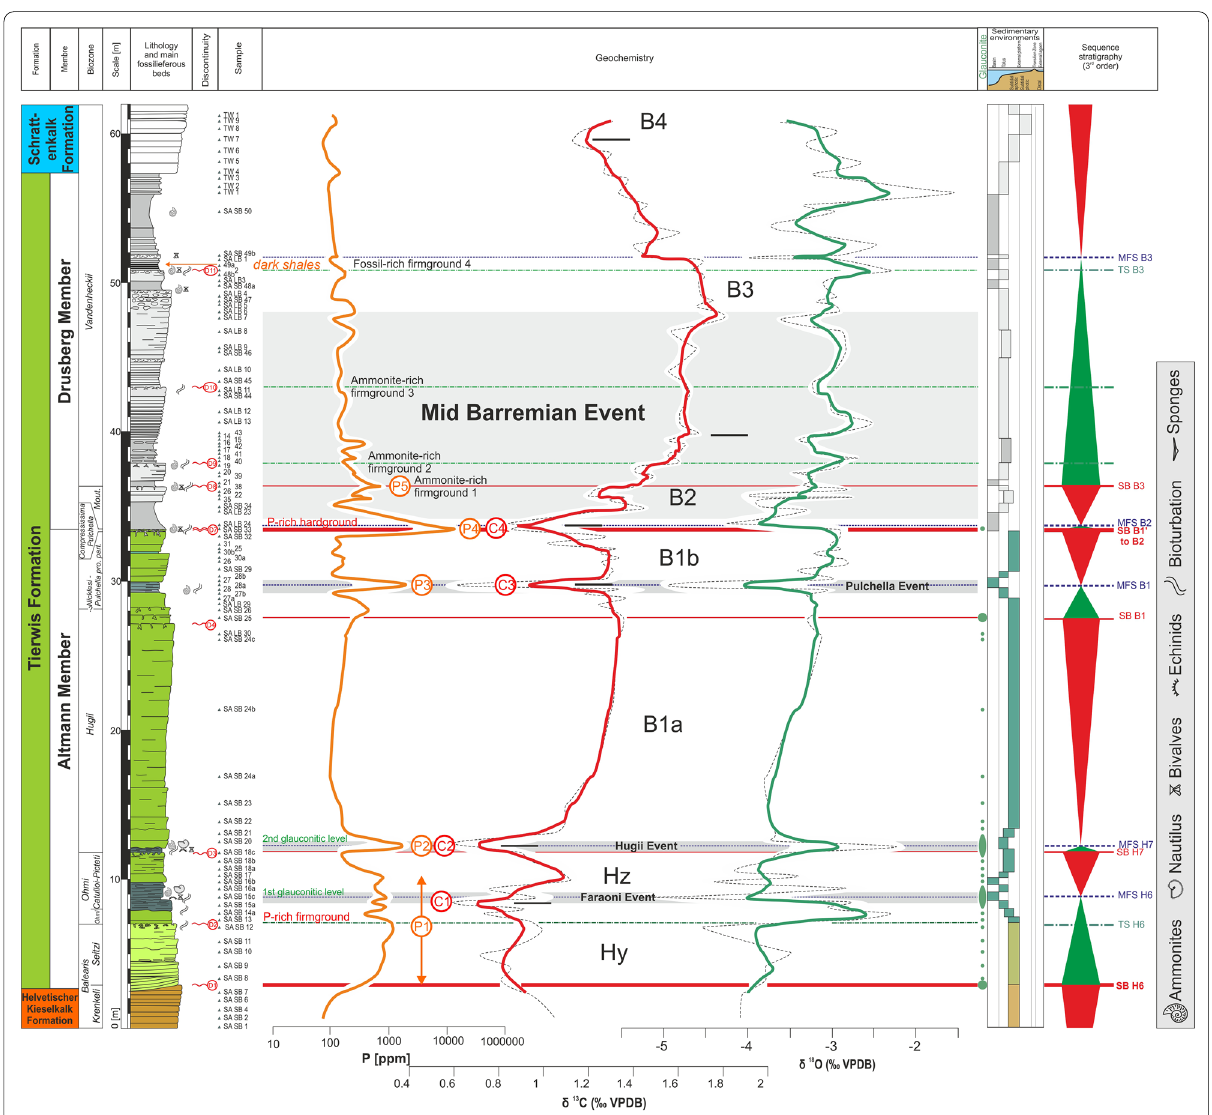
Fig. 5 Tierwis section. Lithological log modified after Bodin et al. (2006b) with main fossil-bearing levels, discontinuities, microfacies, and sequence stratigraphic interpretation. Sequence boundaries (SB) are indicated by bold red lines, transgressive surfaces (TS) by dash–dot green lines, and maximum flooding surfaces (MFS) by dashed blue lines. The phosphorus curve is taken from Bonvallet (2015) and Bonvallet et al. (2019). Sample positions and carbon and oxygen isotopes curves are form Bodin et al. (2006b), Bonvallet (2015), Bonvallet et al. (2019) and Godet et al. (2013). Carbon-isotopic segments B1 to A1 reported on the δ13C curve are labelled after the nomenclature of Wissler (2001), and Wissler et al. (2002, 2003). We split the segment B1 in two subsegments B1a and B1b, and temporary named the two uppermost Hauterivian segments as Hy and